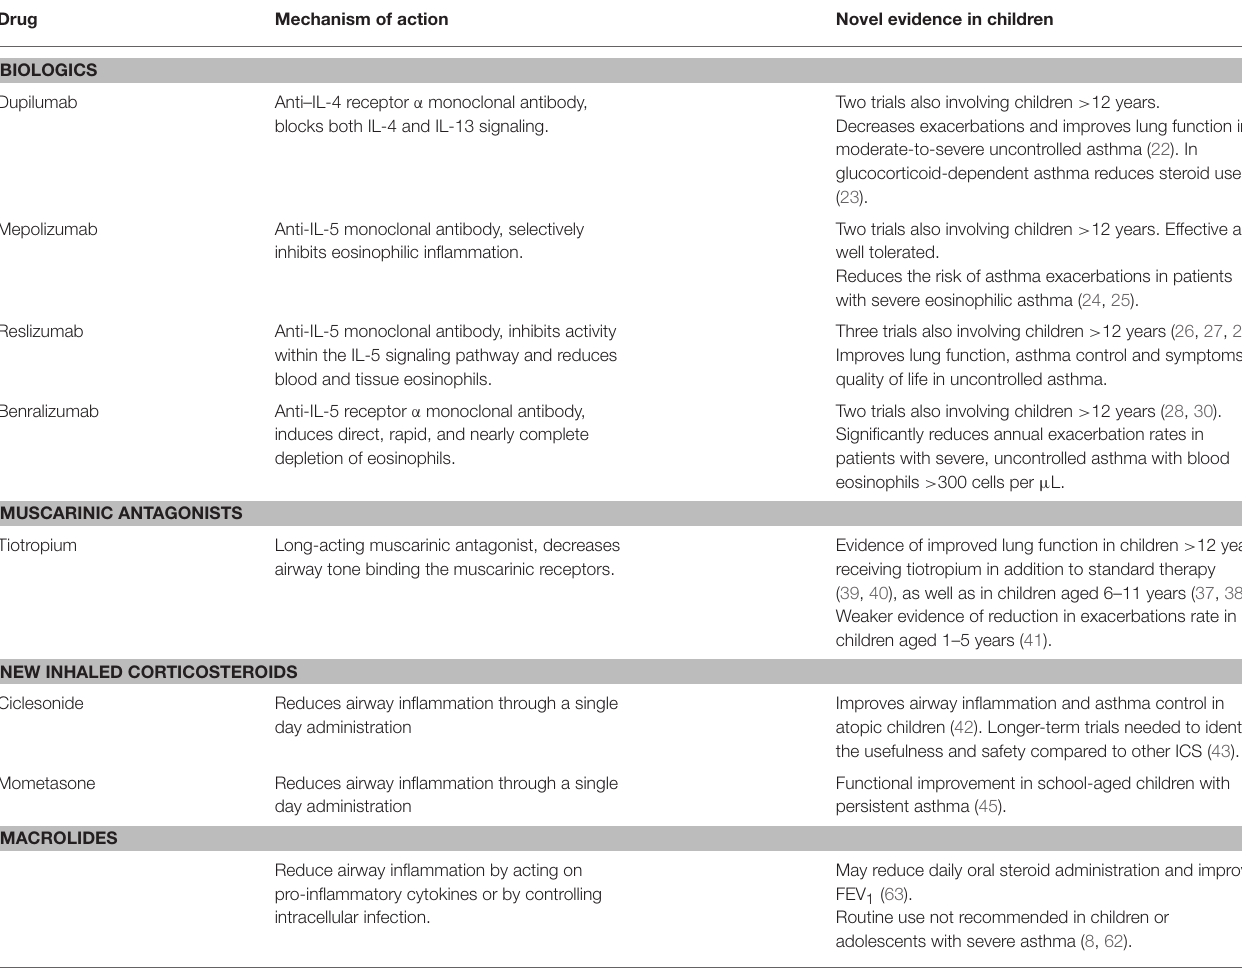
TABLE 1 | Summary of novel drugs for treatment of severe pediatric asthma.